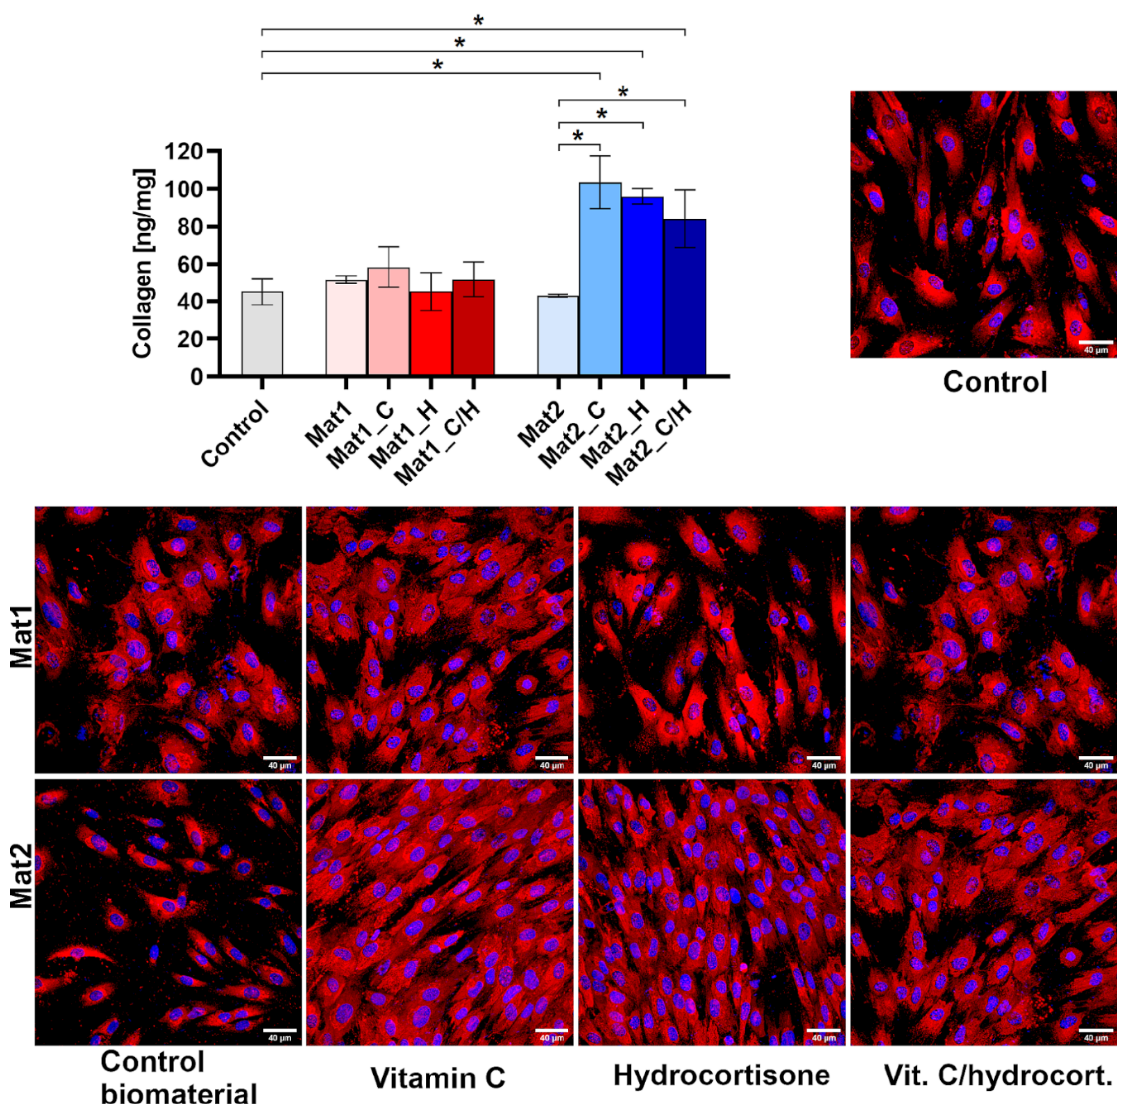
Figure 4. Quantitative (ELISA) and qualitative (immunofluorescence staining) assessment of type I collagen synthesis by human fibroblasts (BJ cell line) after culture in the presence of biomaterials (control–cells culture in the inserts without biomaterial, images: collagen–red fluorescence, nuclei–blue fluorescence, magnification 200×, scale bar = 40 µm); * statistically significant results between indicated groups, p < 0.05, one-way ANOVA followed by Tukey’s test (Mat1: curdlan/agarose biomaterial, Mat2: curdlan/chitosan biomaterial, C–vitamin C, H–hydrocortisone, C/H–mixture of vitamin C and hydrocortisone).